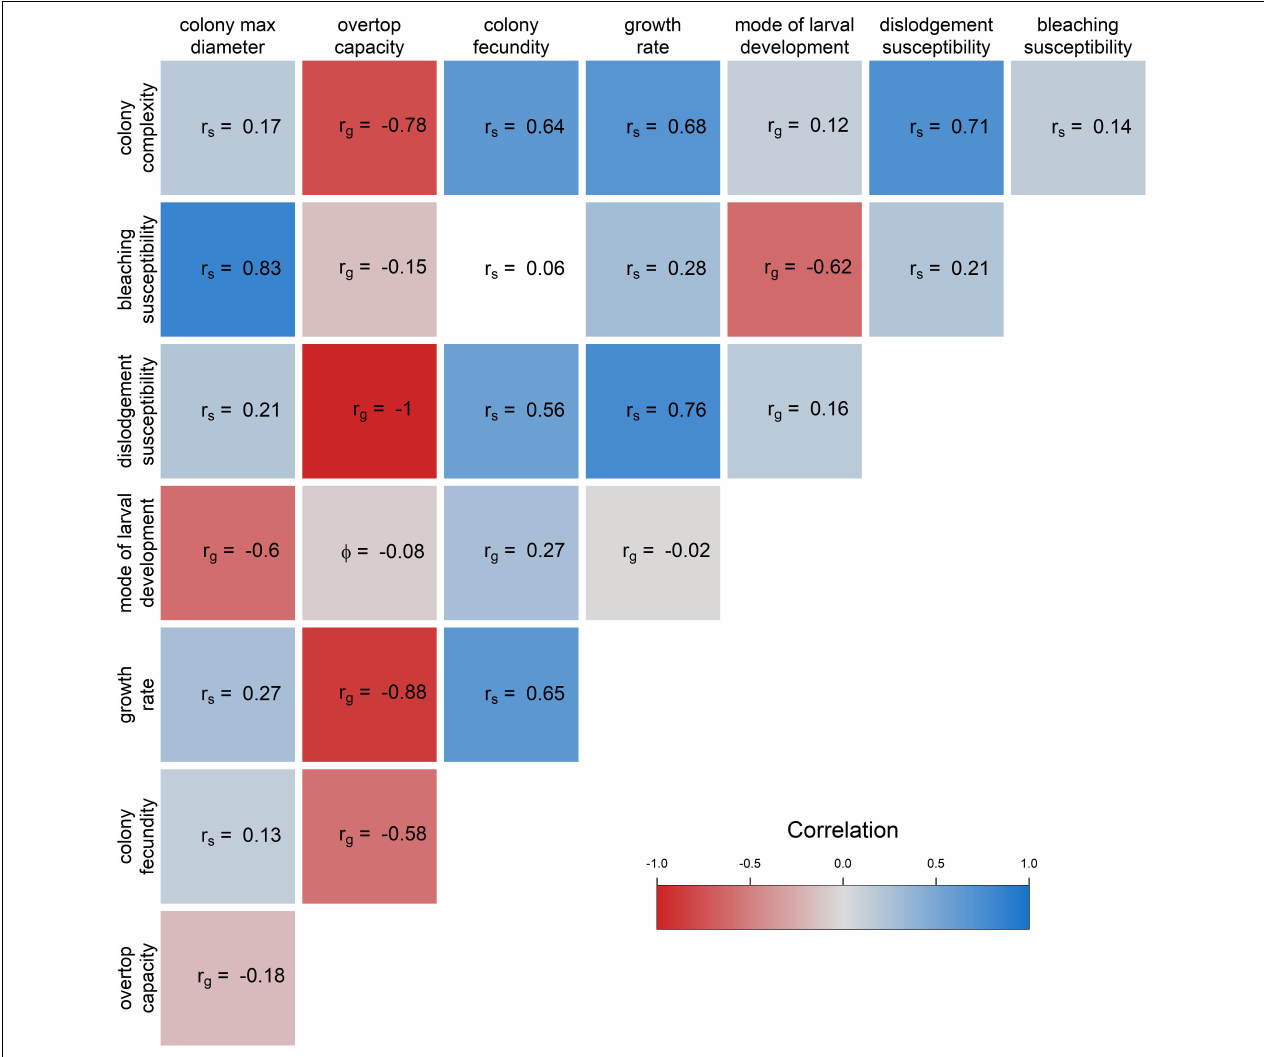
FIGURE 3 | Pairwise correlation matrix of the functional traits ( n = 798) (cf. Table 1 for a complete description of these traits) We used the Spearman’s rank correlation statistic (r s ), the Glass’ rank biserial correlation statistic (r g ) and the mean square contingency coefficient ( φ ) to calculate the correlations between two continuous variables, one continuous and one dichotomous variable and between two dichotomous variables, respectively (cf. Supplementary Figure 9 for a visualization of the